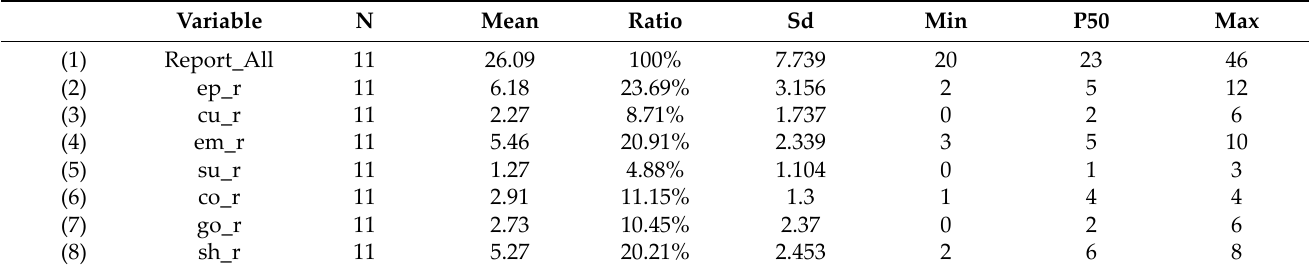
Table 10. Results of total and level‑1 dimension analysis on CSR reports.